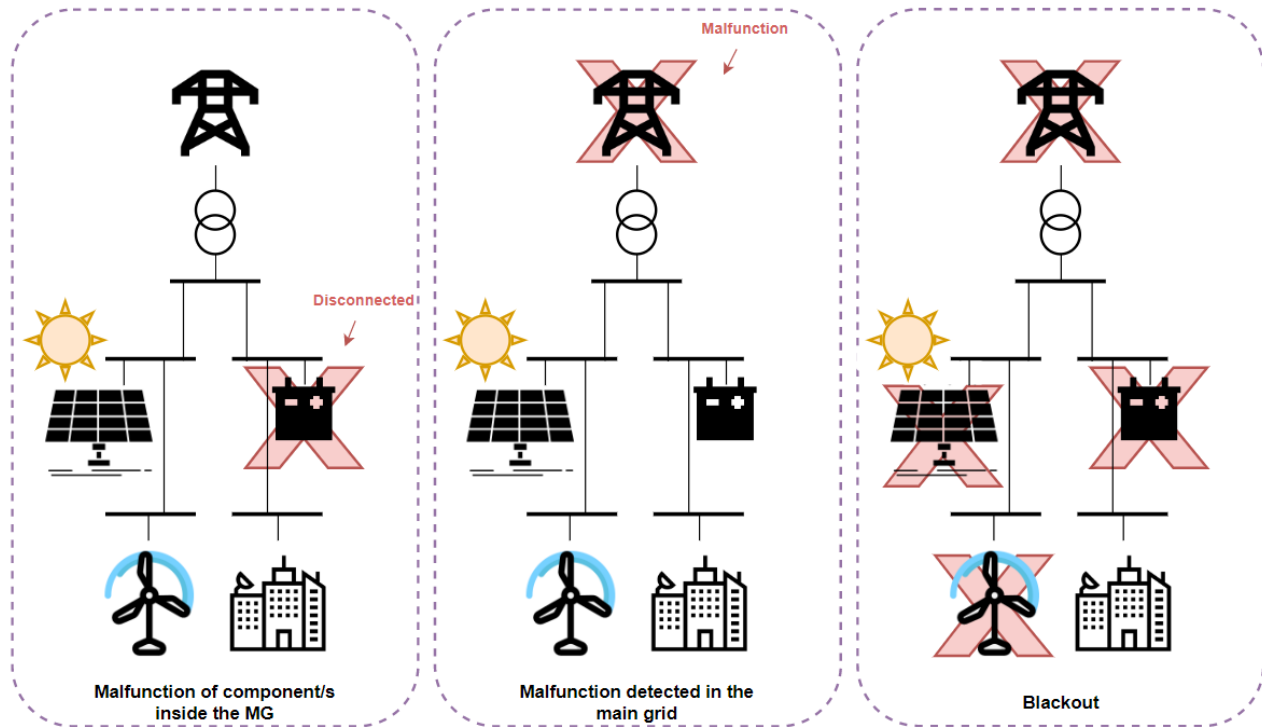
Figure 1 . Main sorts of